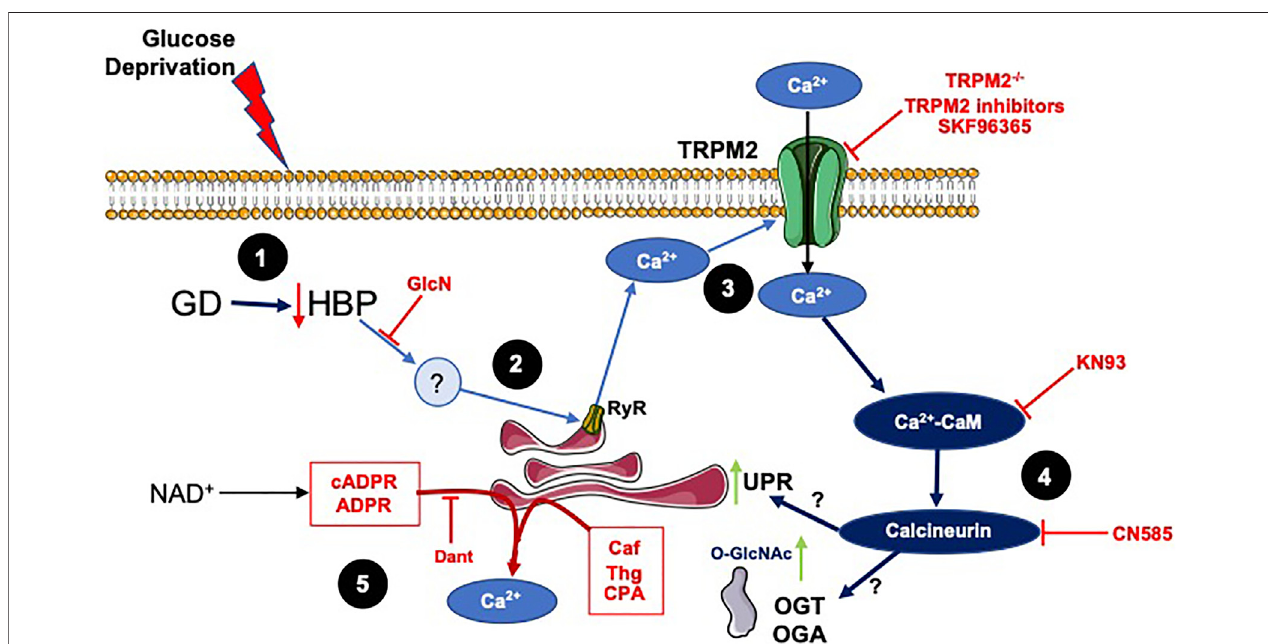
FIGURE 6 | A schematic summarizing the results and illustrating potential mechanisms underlying effects of glucose deprivation on O-GlcNAc and ER stress and how they might be regulated by NAD + and its metabolites: 1) In response to glucose deprivation there is a decrease in HBP fl ux, which is supported by the observation that glucosamine, which is metabolized to UDP-GlcNAc via the HBP, attenuates the responses to glucose deprivation. 2) While the downstream effector of the decreased HBP fl ux has yet to be identi fi ed, a likely candidate would the loss of O-GlcNAc from speci fi c site(s) on a protein(s) subsequently triggering a release of Ca 2+ fromtheER/SR. Thisissupported byobservations thatinterventionsthatdecrease ER/SRCa 2+ levelsattenuate theresponsestoglucose deprivation. 3)Inhibition ofTRPM2orlossofTRPM2blockedtheglucosedeprivationresponses,suggestingthatitsactivation via glucosedeprivation resultedinanin fl uxofextracellularCa 2+ .In addition,ER/SRCa 2+ releasehasbeenshowntobesuf fi cienttoactivateTRPM2channels. ThisissupportedbyearlierobservationsthatextracellularCa 2+ wasrequired for the glucose deprivationinducedincrease in O-GlcNAc (Zou et al., 2012) and thatinhibitionofdownstreamCa 2+ signaling pathways bluntedthe increaseinER stress and O-GlcNAc in response to glucose deprivation. In addition, SKF96365 a SOCE inhibitor, which also attenuates the response to glucose deprivation, is reported to inhibitmembersofthetransientreceptorpotentialfamilyincludingTRPM2channels(Hartenecketal.,2011).4)TheTRPM2mediatedin fl uxofCa 2+ activatesCa 2+ /CaM- dependent pathway, which potentially via activation of calcineurin leads to increased ER stress and O-GlcNAc levels. This is supported by the observation that KN93 a CaMKIIandCa 2+ /CaMinhibitorandCN585,acalcineurininhibitor,attenuatedtheresponsestoglucosedeprivation.ThelinksbetweenCa 2+ /CaMandtheincreaseinER stress and O-GlcNAc following glucose deprivation are currently not known, although calcineurin has been associated with activation of ER stress (Carreras-Sureda et al., 2018). 5) The NAD + metabolites, cADPR and ADPR, are known to activate the RyR releasing ER/SR Ca 2+ and caffeine a RyR agonist all attenuate the cellular responsestoglucose deprivation.TheSERCA inhibitors thapsigargin(Thg)andCPA,whichdecrease ER/SRCa 2+ levels alsoblunttheresponse toglucose